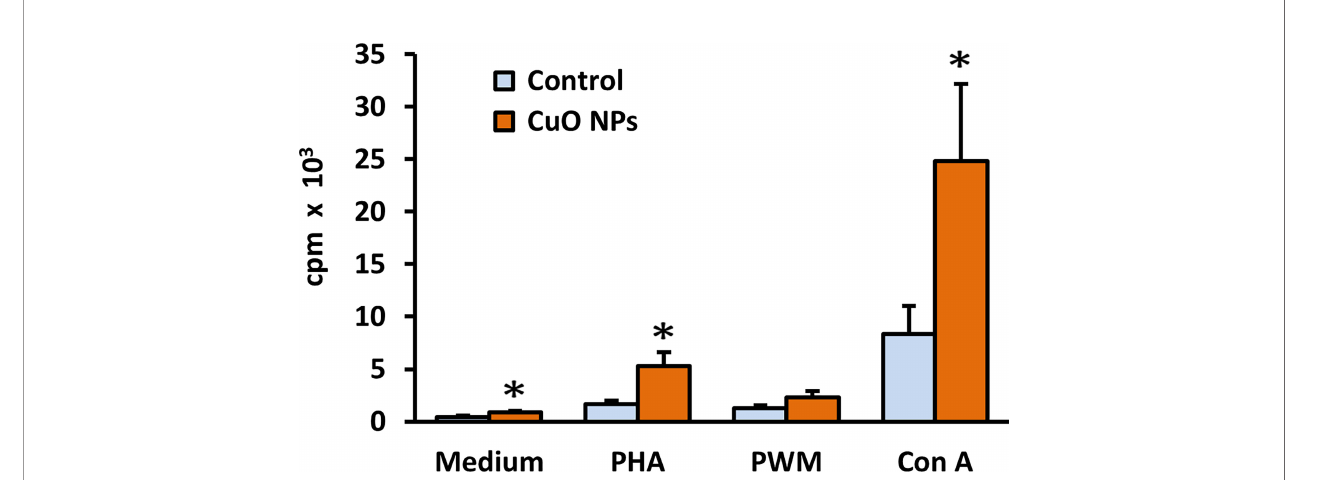
FIGURE 4 | Proliferative activity of spleen lymphocytes in mice after 6-week inhalation of CuO NPs. The proliferative response of spleen T-lymphocytes and T- dependent B-cell response in mice was measured as incorporation of [ 3 H]-thymidine into replicating cells. Control – control group (n = 8), CuO NPs – group exposed to CuO NPs (n = 7). Spleen cells were derived from mice and in vitro stimulated with mitogens: medium – unstimulated cells, PHA – phytohemagglutinin, PWM – pokeweed mitogen, Con A – concanavalin A. Results are expressed as cpm (counts per minute) in thousands per well. Bars indicate mean group values (mean + SEM). Signi fi cance: *p < 0.05.